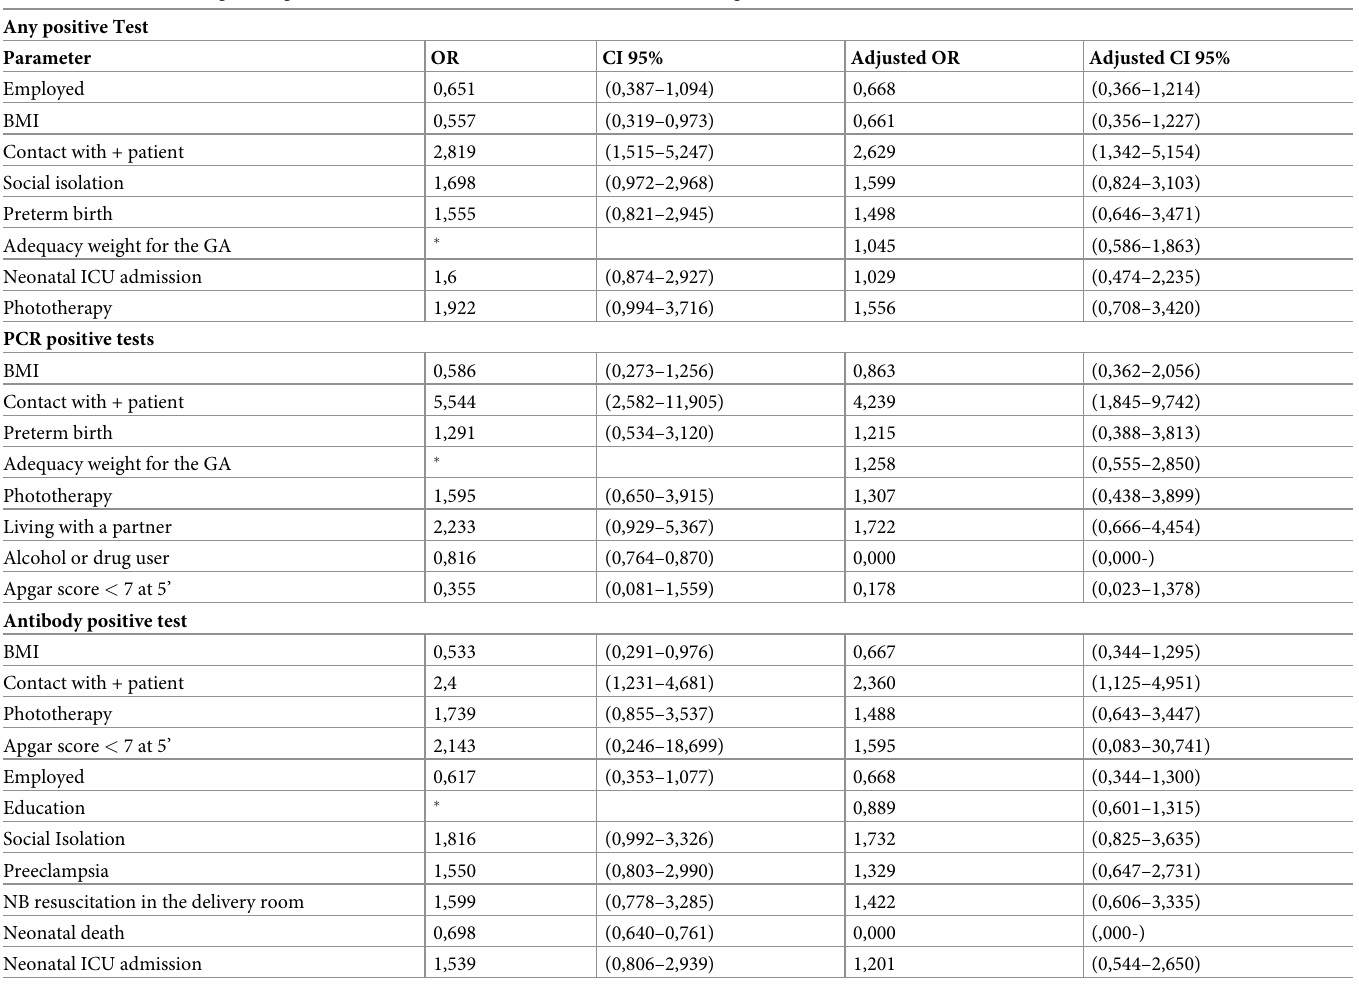
Table 3. Final model of logistic regression of covariates associated with SARS-CoV-2 diagnostic